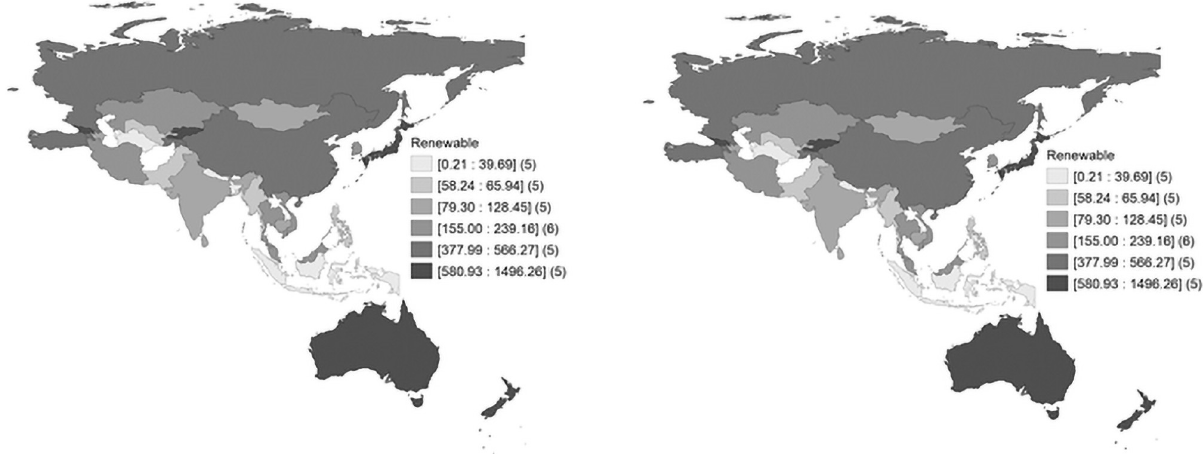
Fig 1. Corban emissions per capita and renewable energy per capita.